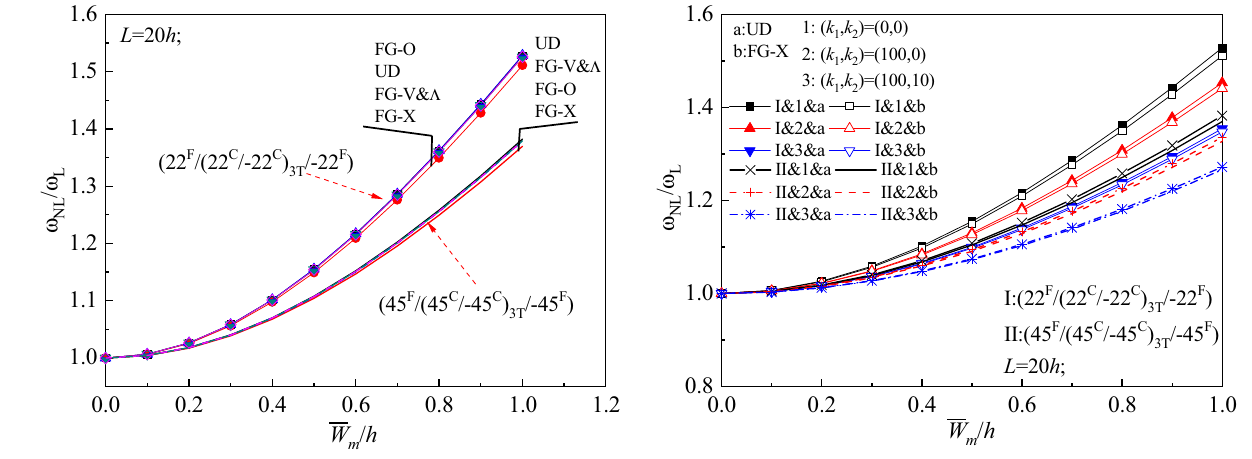
Figure 8: Amplitude curves for hybrid plates with NPR or PPR.